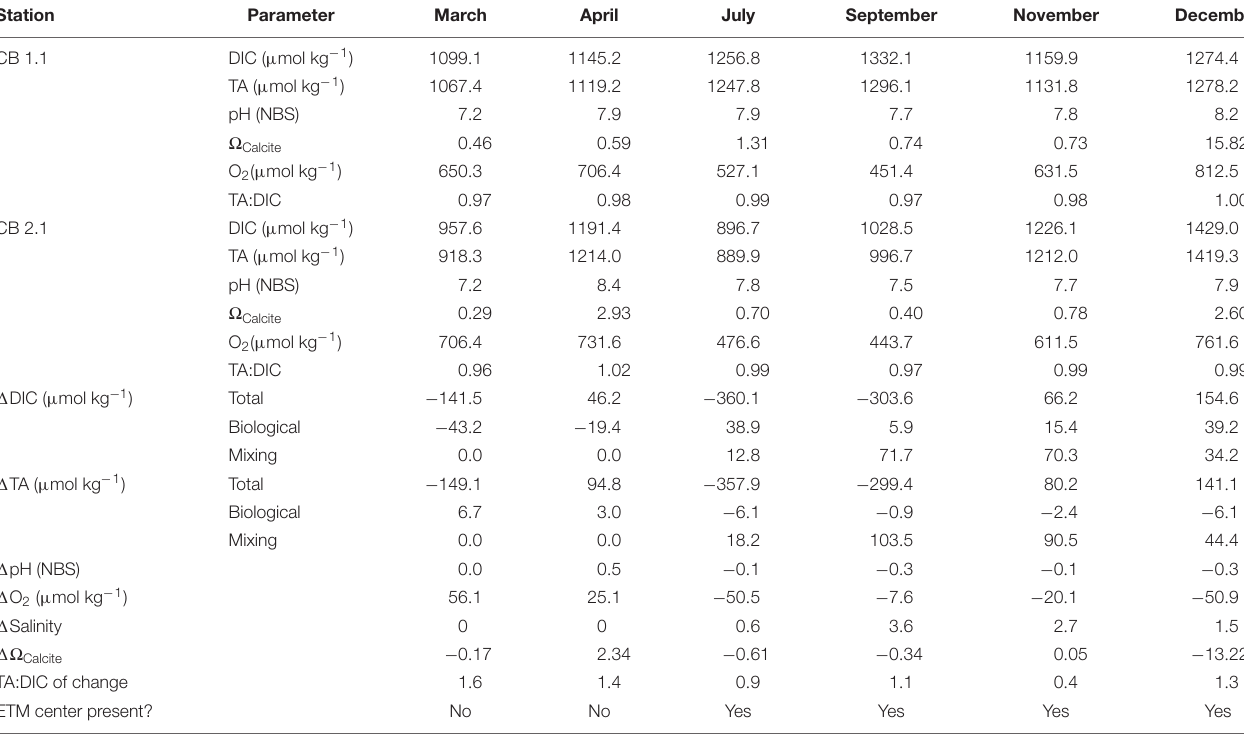
TABLE 3 | Change in surface water chemistry across the Susquehanna Flats between CB 1.1 and CB 2.1. Station